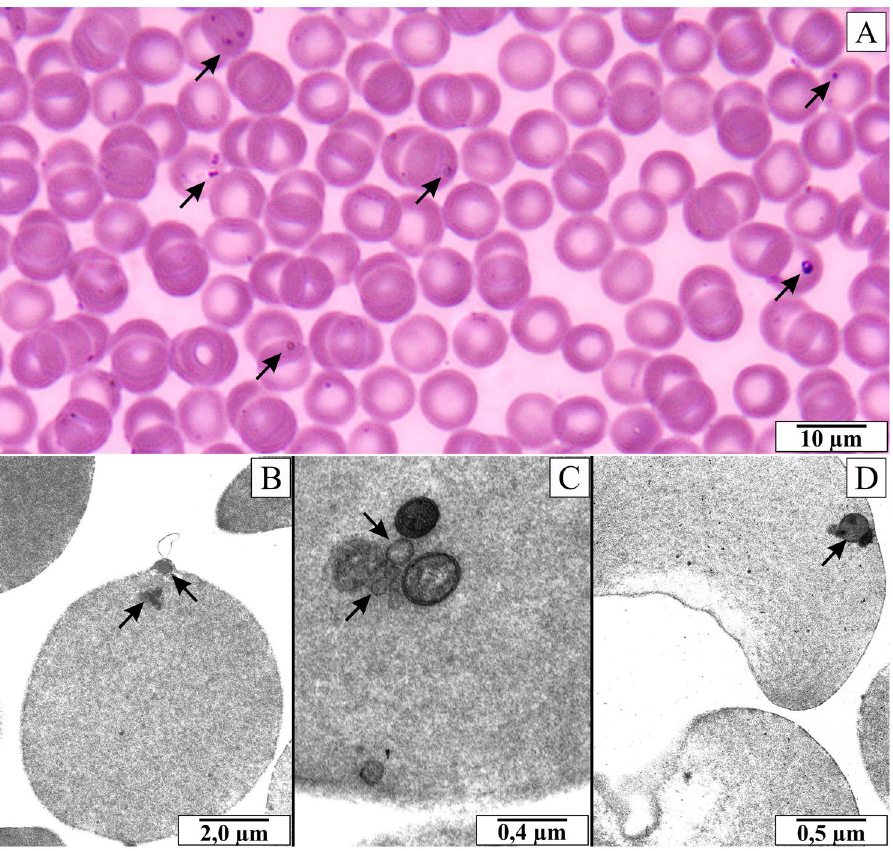
Figure 1. Blood smear of rats infected with B. microti . ( A ) blood smear stained by the May-Grünwald-Giemsa method. ( B – D ) electronmicrographs of blood cells. Arrows indicate different forms of B. microti merozoites inside